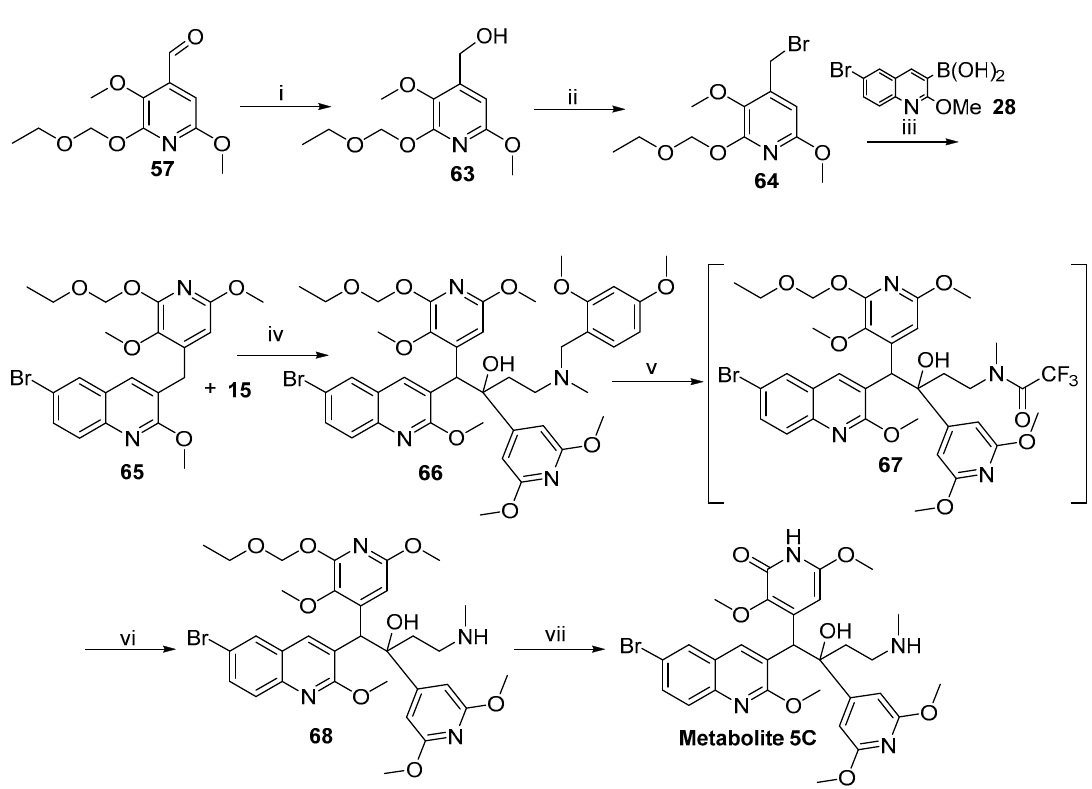
Scheme 16. Synthesis of key intermediate 65 and metabolite 5C . Reagents and conditions: (i) NaBH 4